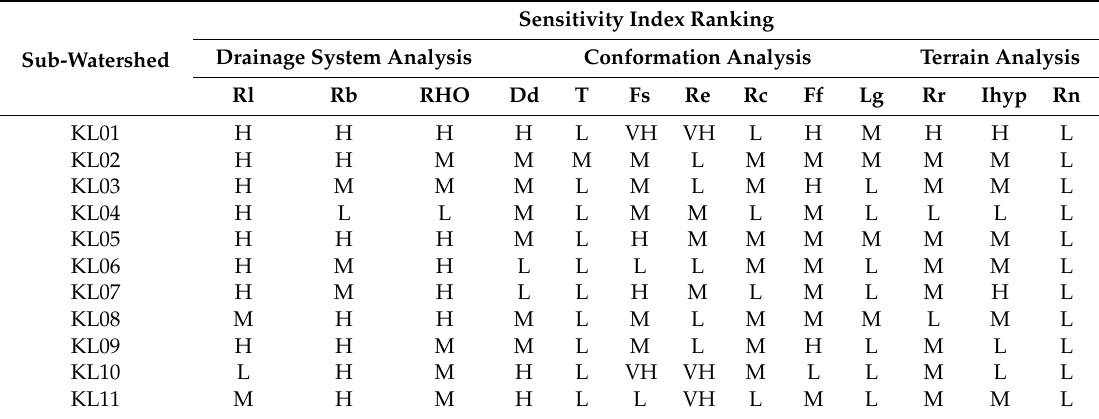
Table 5. Sensitivity index ranking of watershed prioritization in KLs